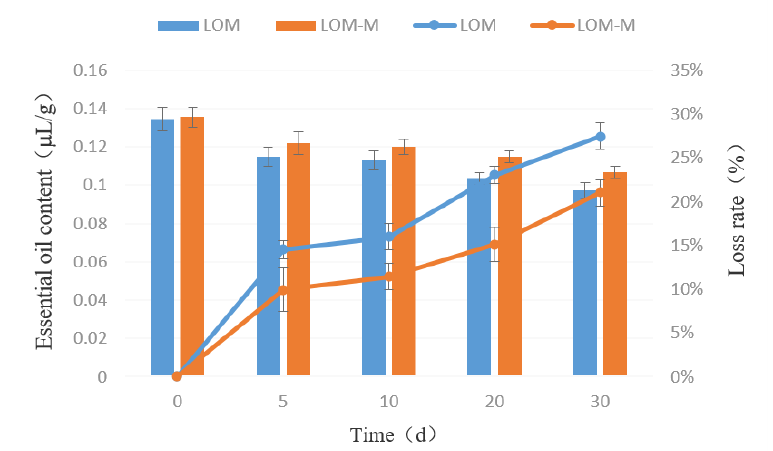
Figure 5. The release of lavender essential oil in single-layered microcapsules (LOM) and double-layered microcapsules (LOM-M) at room temperature.